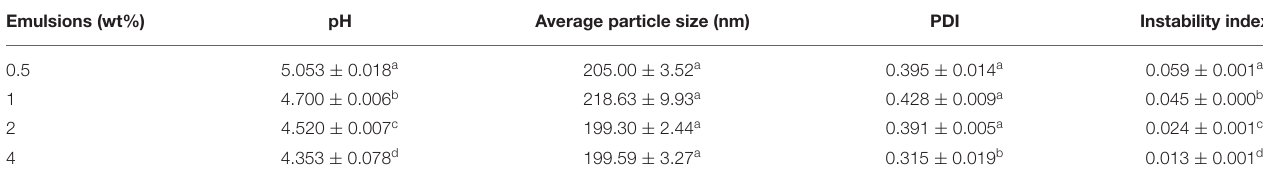
TABLE 1 | The characterization of galangal essential oil